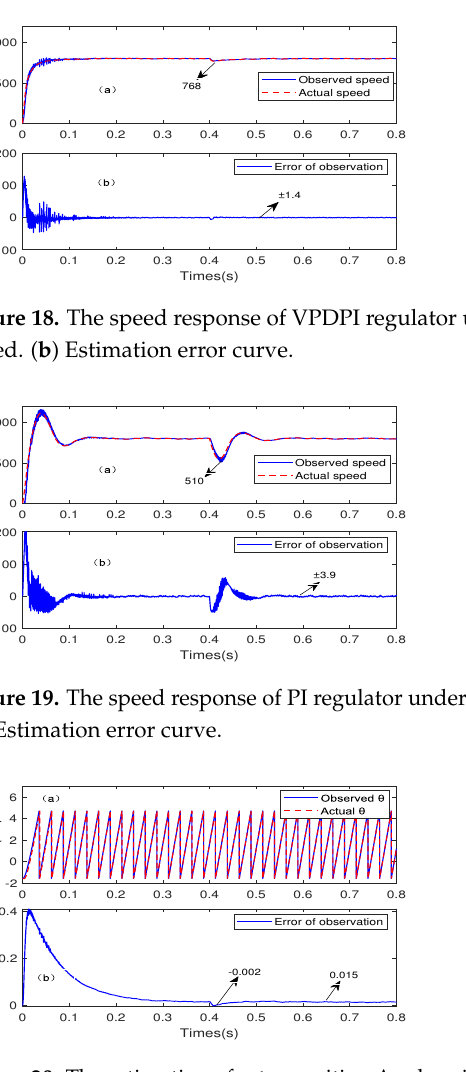
Figure 20. The estimation of rotor position Angle using VPDPI. ( a ) Observed and actual rotor position Angle. ( b ) Rotor position Angle observation